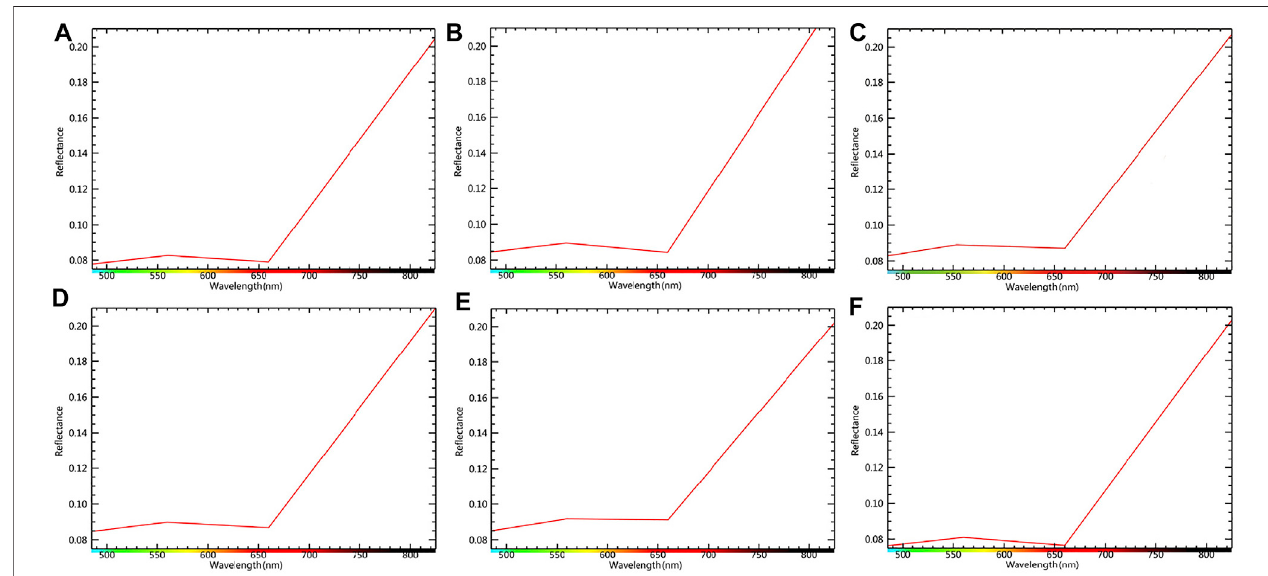
FIGURE 5 | The spectral re fl ectance curves of vegetation with different image fusion methods (A) MS image (B) Pansharpening fused image (C) HPF fused image (D) GS fused image (E) PCA fused image (F) NND fused image.